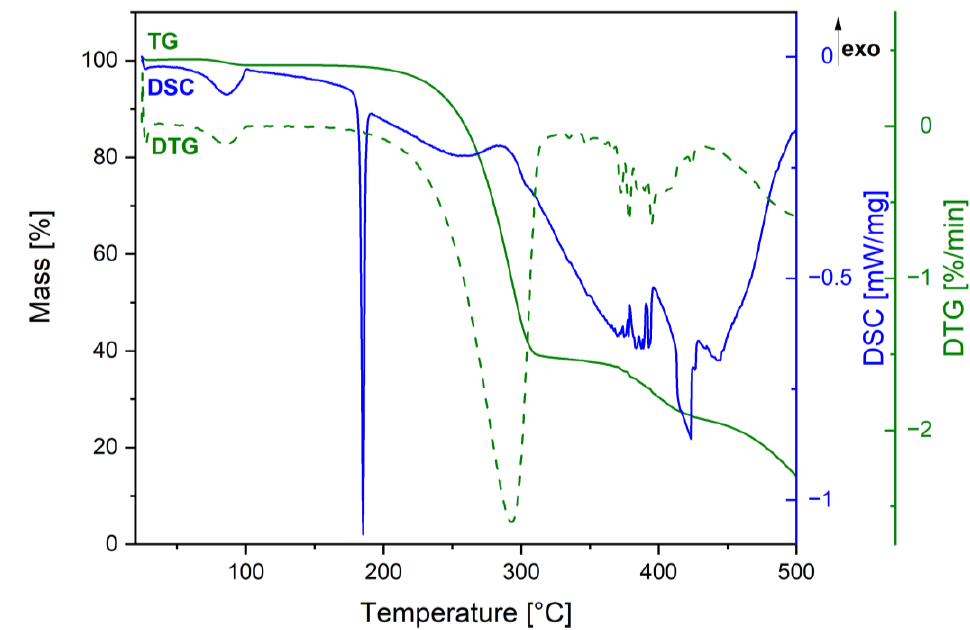
Figure 3. Simultaneous − determined TG (thermogravimetric), DTG (derivative thermogravimetric), and DSC (differential scanning calorimetry) curves in air atmosphere at β = 2 °C/min for EE on temperature range 25 – 500 °C.